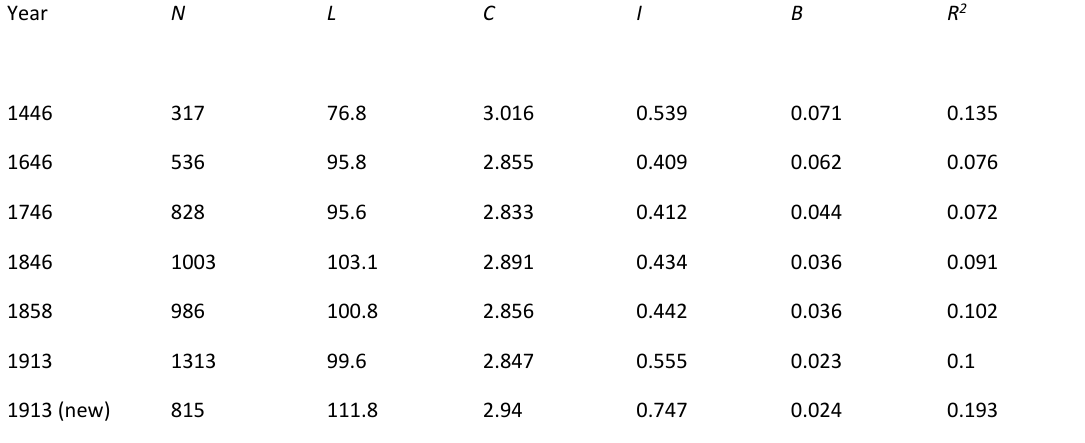
Table 1 Measures of axial map analysis of Shkodër’s street network compared across six historical stages 1446 -1913, and the new part of the city in 1913 considered separately: number of axial lines N , mean values of length L , connectivity C , integration I , and normalized choice B , and the index of intelligibility measured with the regression coefficient R 2 in C vs I